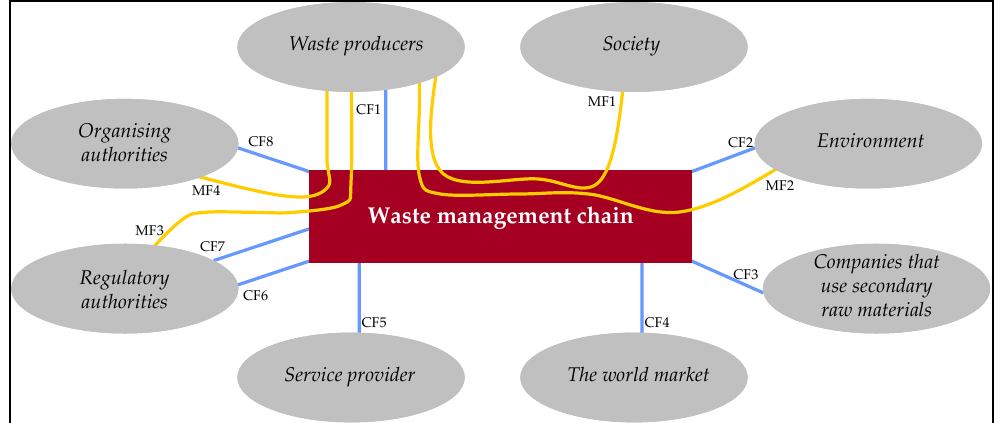
Figure 2 : External functional block diagram of waste management system 8 Fig. 2. External functional block diagram of a waste management